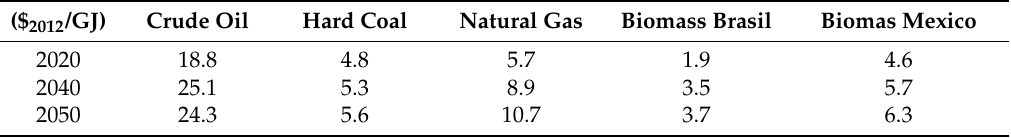
Table 5. Fuel price assumptions in $ 2012